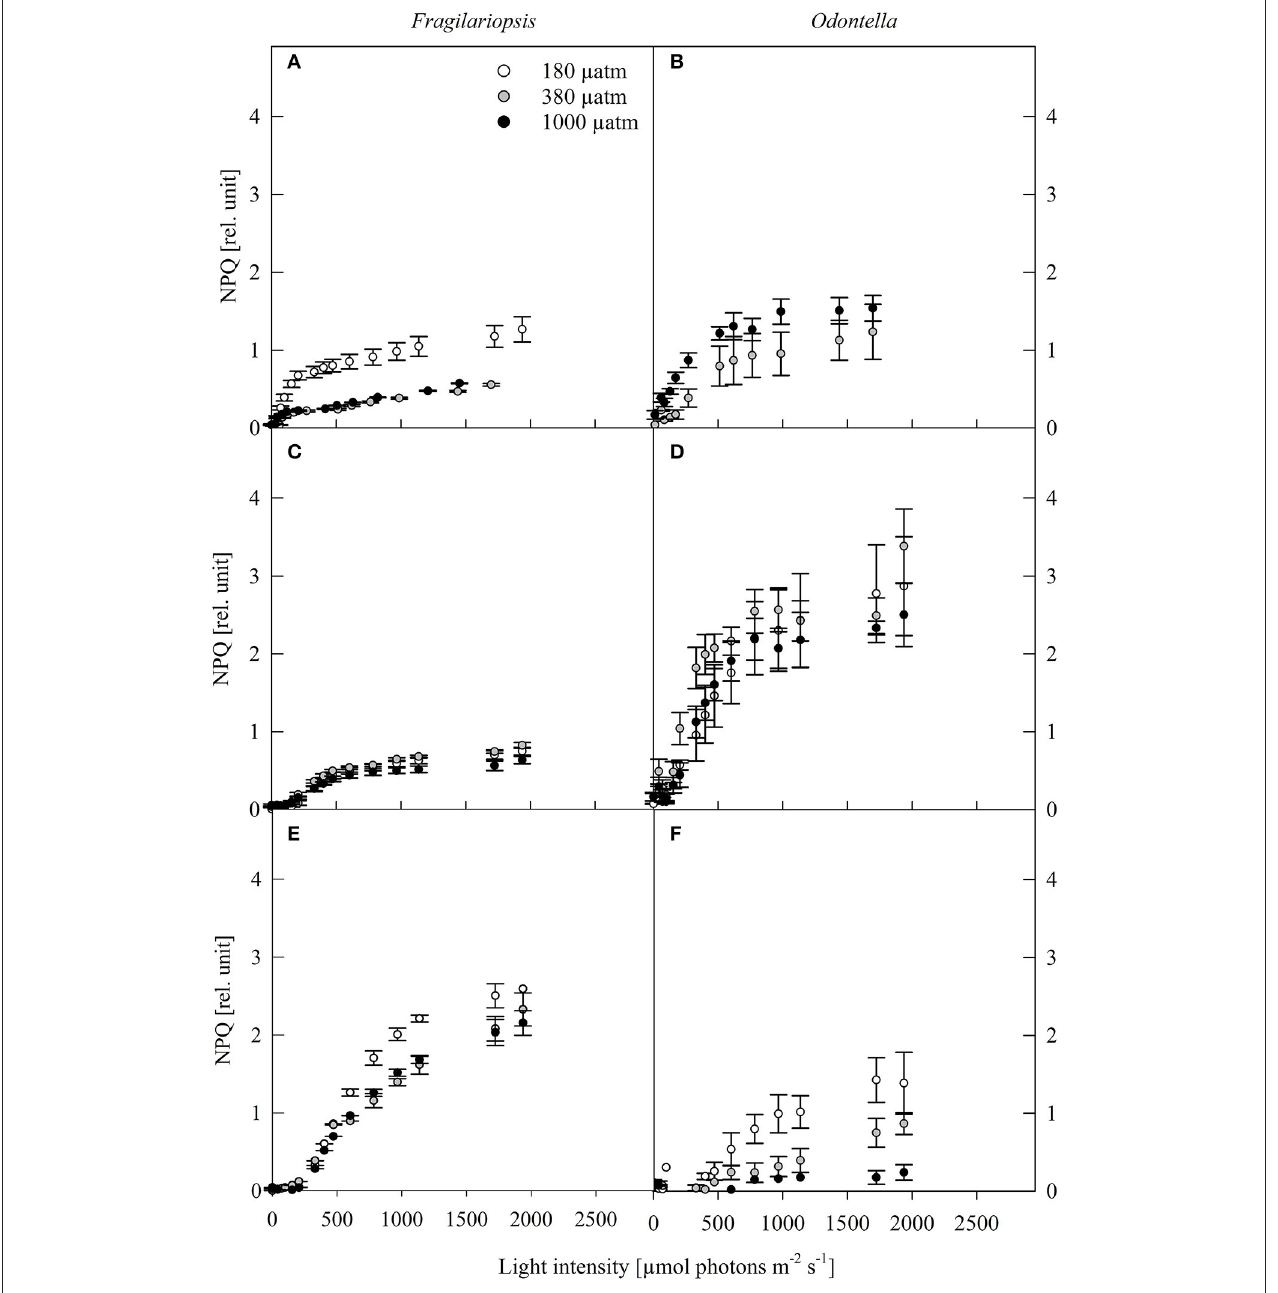
FIGURE 4 | Non-photochemical quenching (NPQ, rel. unit) was determined in response to increasing irradiances in Fragilariopsis and Odontella acclimated to different light (LL = 20 in A,B ; ML = 200 in C,D ; HL = 500 µ mol photons m − 2 s − 1 in E,F ) and pCO 2 (low = 180, ambient = 380 and high = 1000 µ atm) conditions. Values represent mean ± SE ( n =